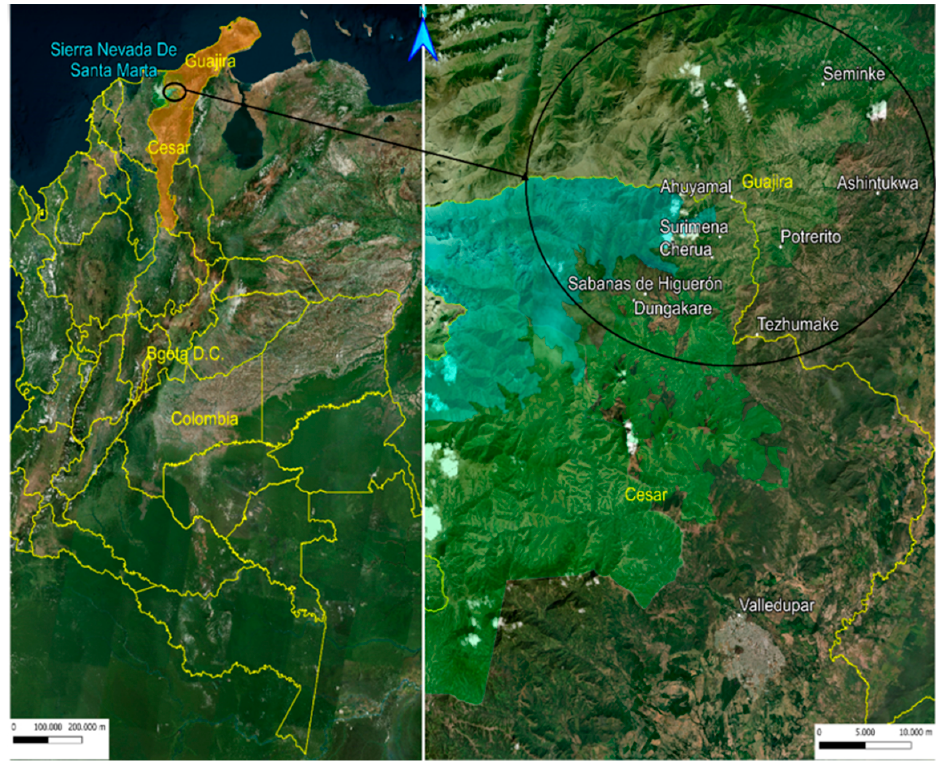
Figure 1. Maps of Colombia and Wiwa indigenous settlements, map made with Qgis Hannover 3.16 (https://wwwqgis.org/es/site/) modified by H. Soto, 12 July 2022.